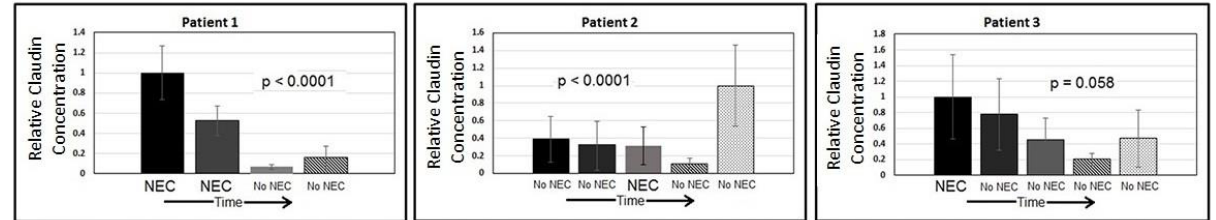
Figure 2: All three patients with diagnosed NEC had spikes in their urinary claudi-2 levels during their NICU admission. Patient 1 and Patient 3 had spikes that directly coincided with their having active NEC.